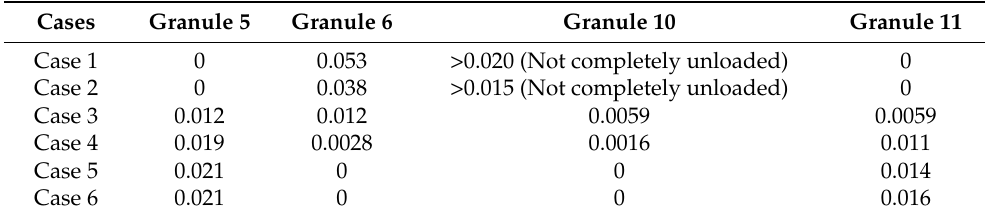
Table 4. Residual deformation of granules at the